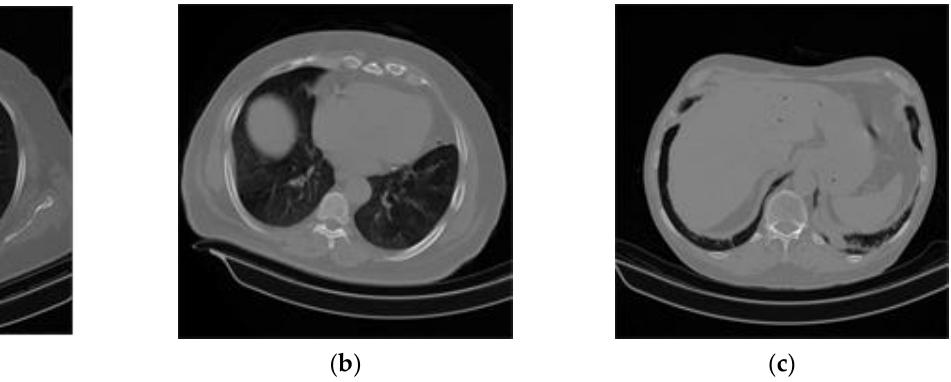
Table 3. Per class X-ray images applied in training and testing phases.